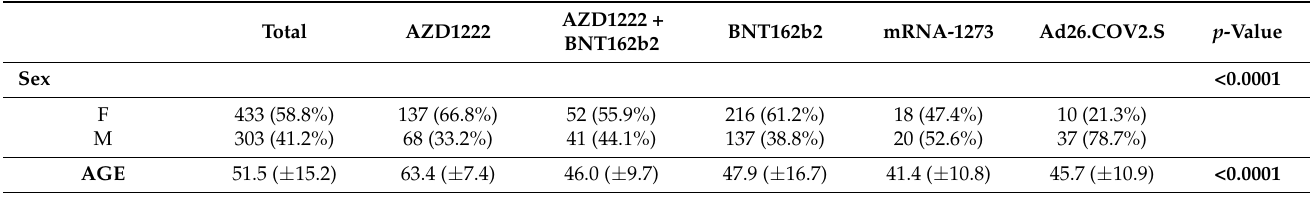
Table 1. Subject recruitment criteria in the